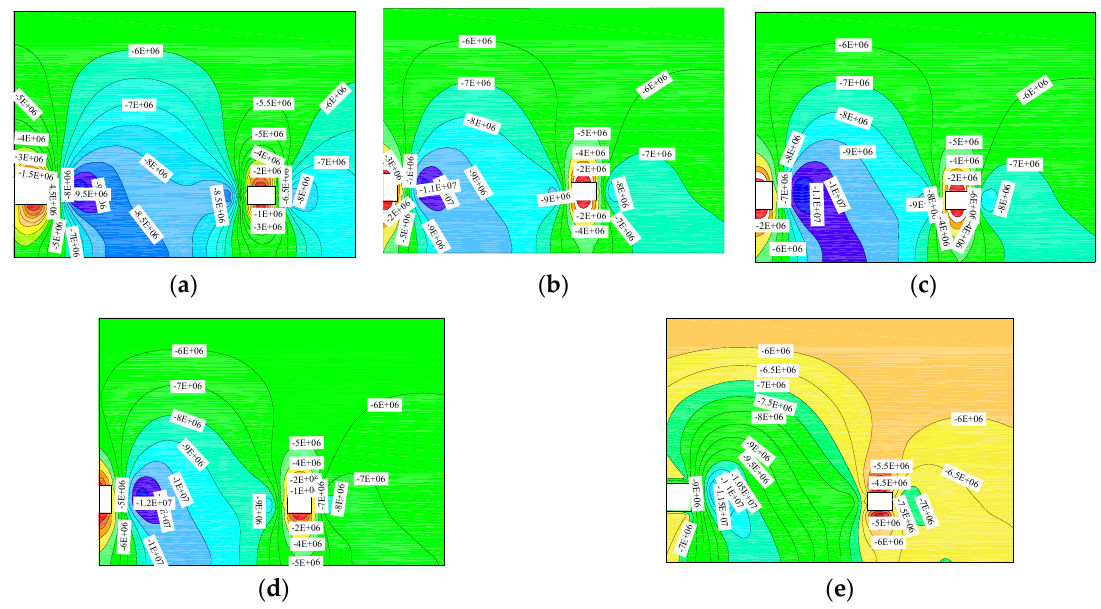
Figure 12. Vertical stress (Pa) of surrounding rock with different excavation distances: ( a ) 40 m; ( b ) 60 m; ( c ) 80 m; ( d ) 100 m; and, ( e ) 120 m.